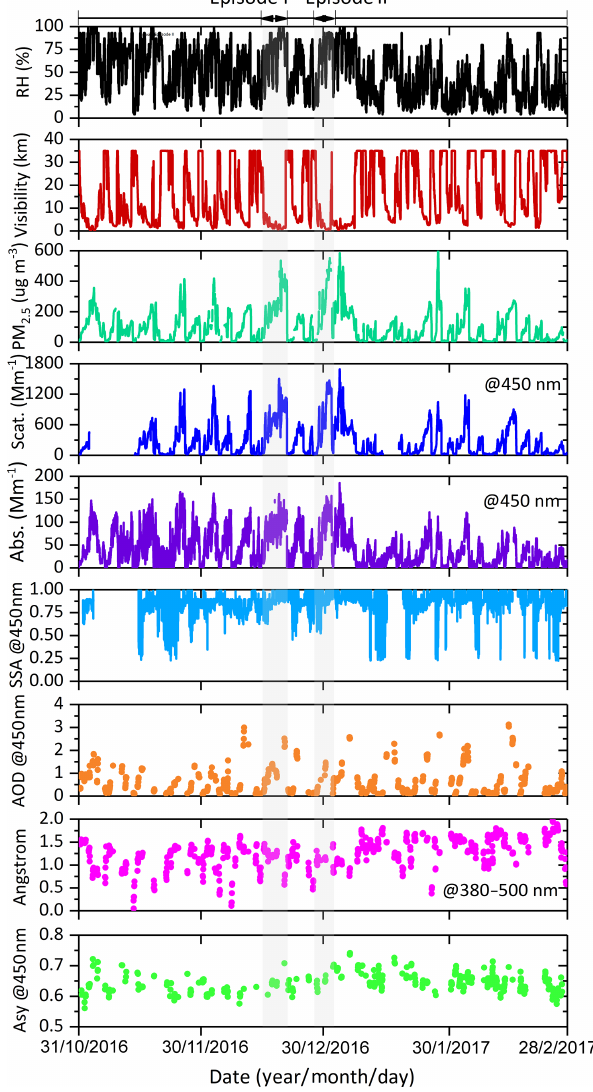
Figure 2. Time series of PM 2 . 5 and AOPs ( σ sca , σ abs , SSA, AOD, Ångström exponent, and asymmetry factor) and meteorological pa- rameters (relative humidity and visibility) during the observation in Beijing from November 2016 to February